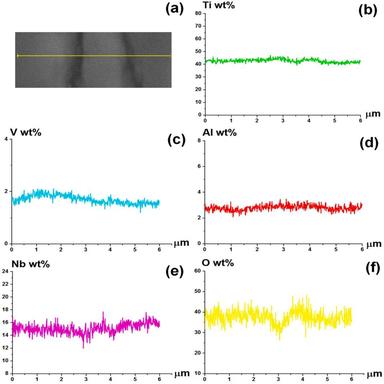
(a) SEM image used to EDX analysis of Ti6Al4V alloy containing Nb2O5 thin film from the top, (b-f) the variation in the chemical composition (wt %) along with the microstructure.